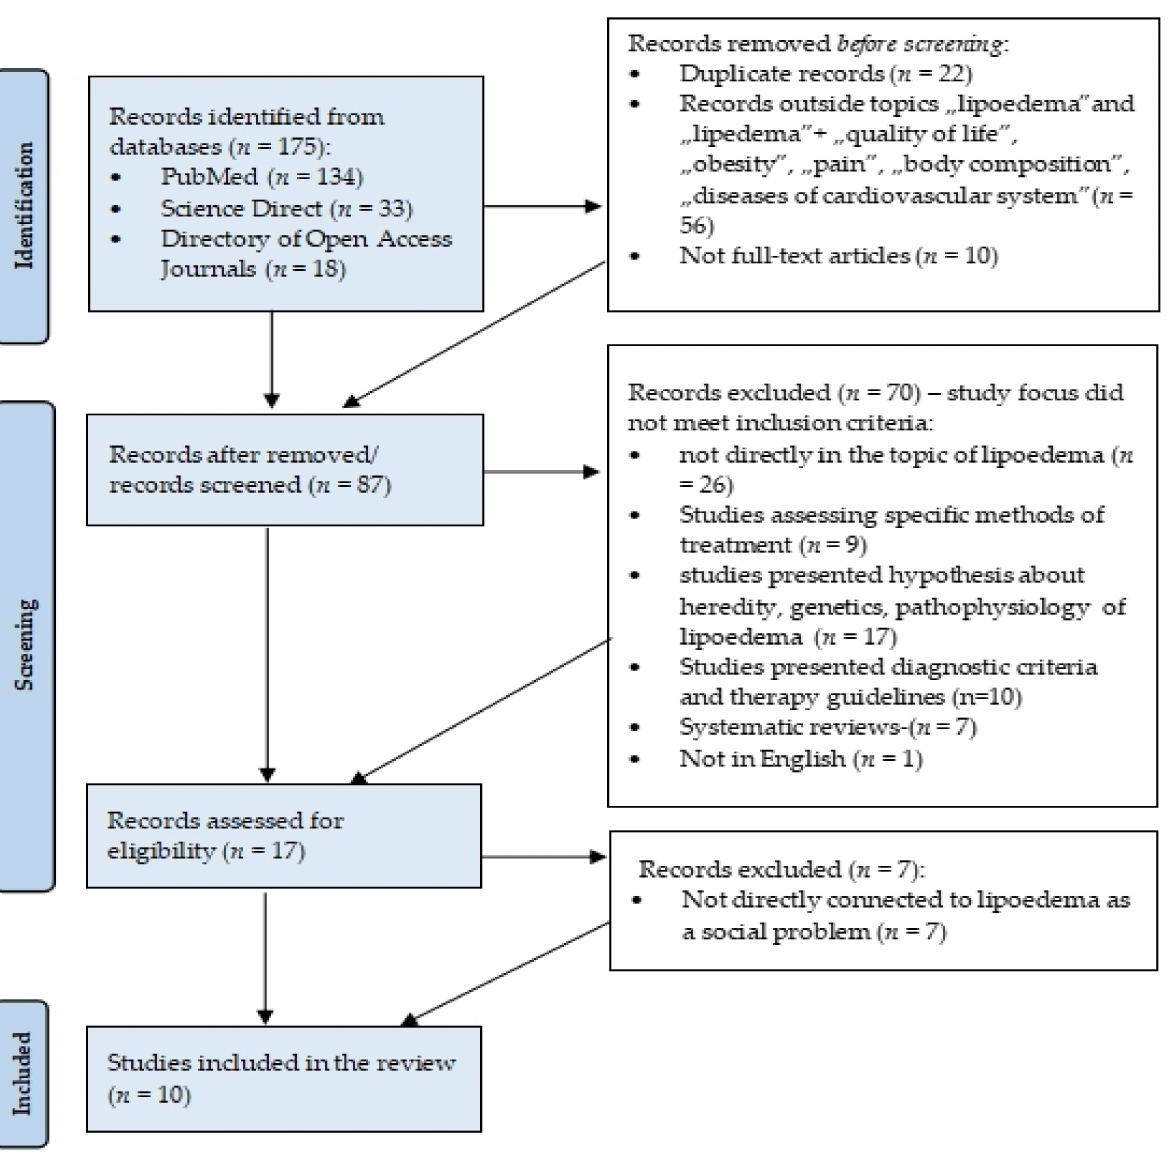
Figure 1. Flow diagram adapted from PRISMA which shows the process for identifying and screening the articles for inclusion and